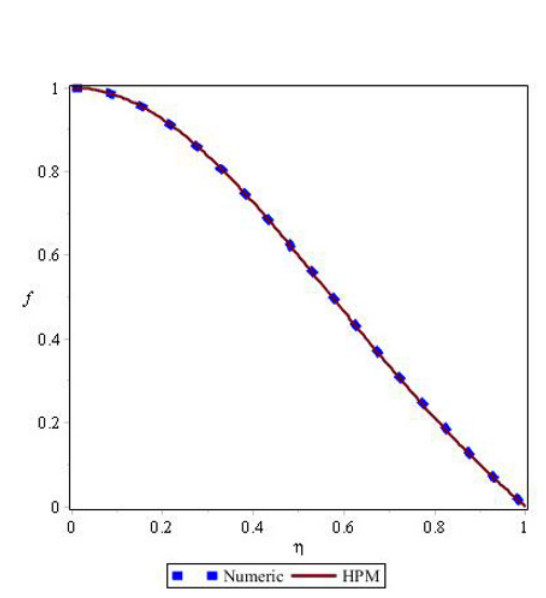
Figure 10. Comparison between the obtained solutions for f HPMandNumericalMethod( A ∗ = 1 , Ha = 0 , Re = 150 , α = 1 ◦ , φ = 0 ).